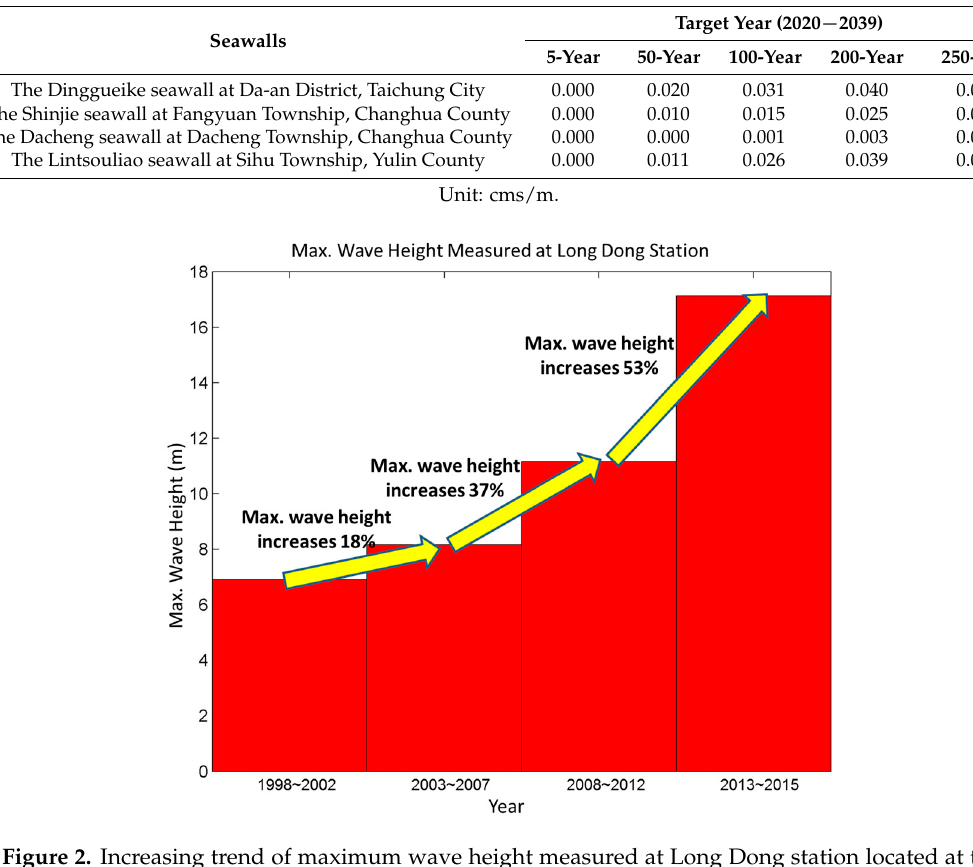
Table 4. The amount of overtopping of different return periods at different places for the target’s future. Seawalls